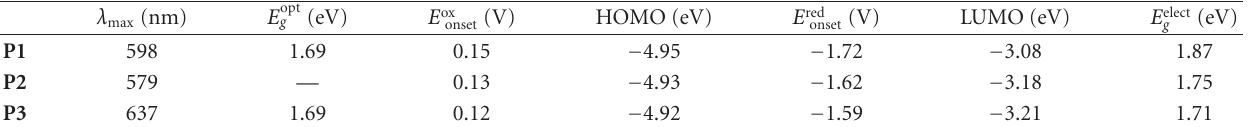
Table 2: Summary of optical and electrochemical properties.